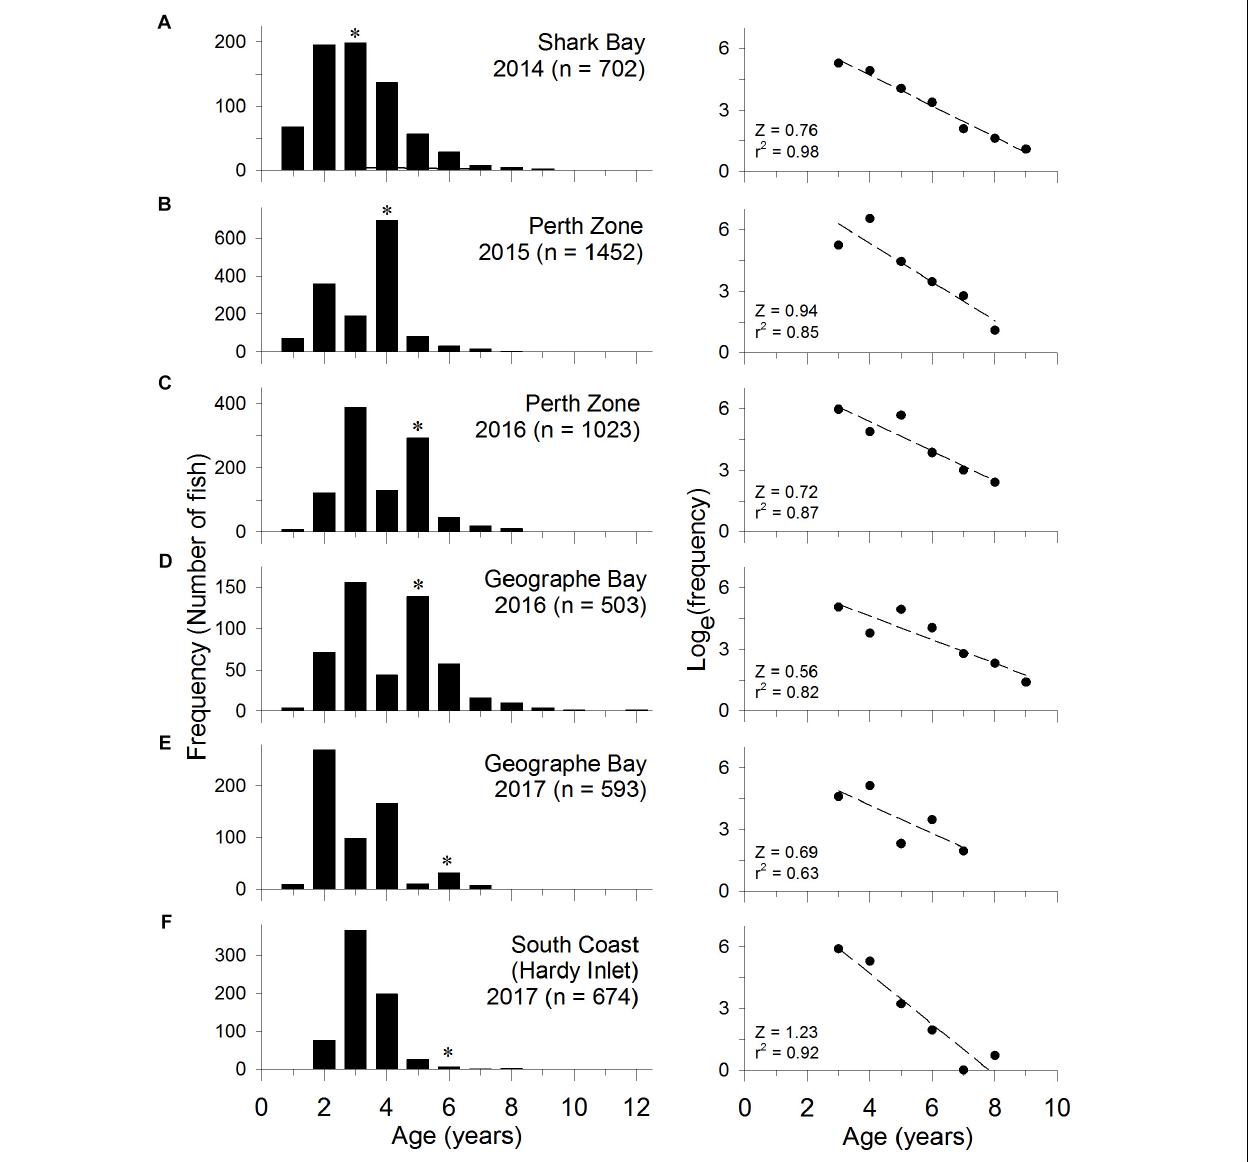
FIGURE 6 | Age frequency distribution of S. schomburgkii in fishery catches sampled at (A) Shark Bay in 2014, (B) Perth Zone in 2015, (C) Perth Zone in 2016, (D) Geographe Bay in 2016, (E) Geographe Bay in 2017, and (F) South Coast (Hardy Inlet only) in 2017. ( ∗ year class spawned during 2010/2011). Raw frequencies shown in left column and natural log transformed values in right column, with linear regression fitted to fully selected